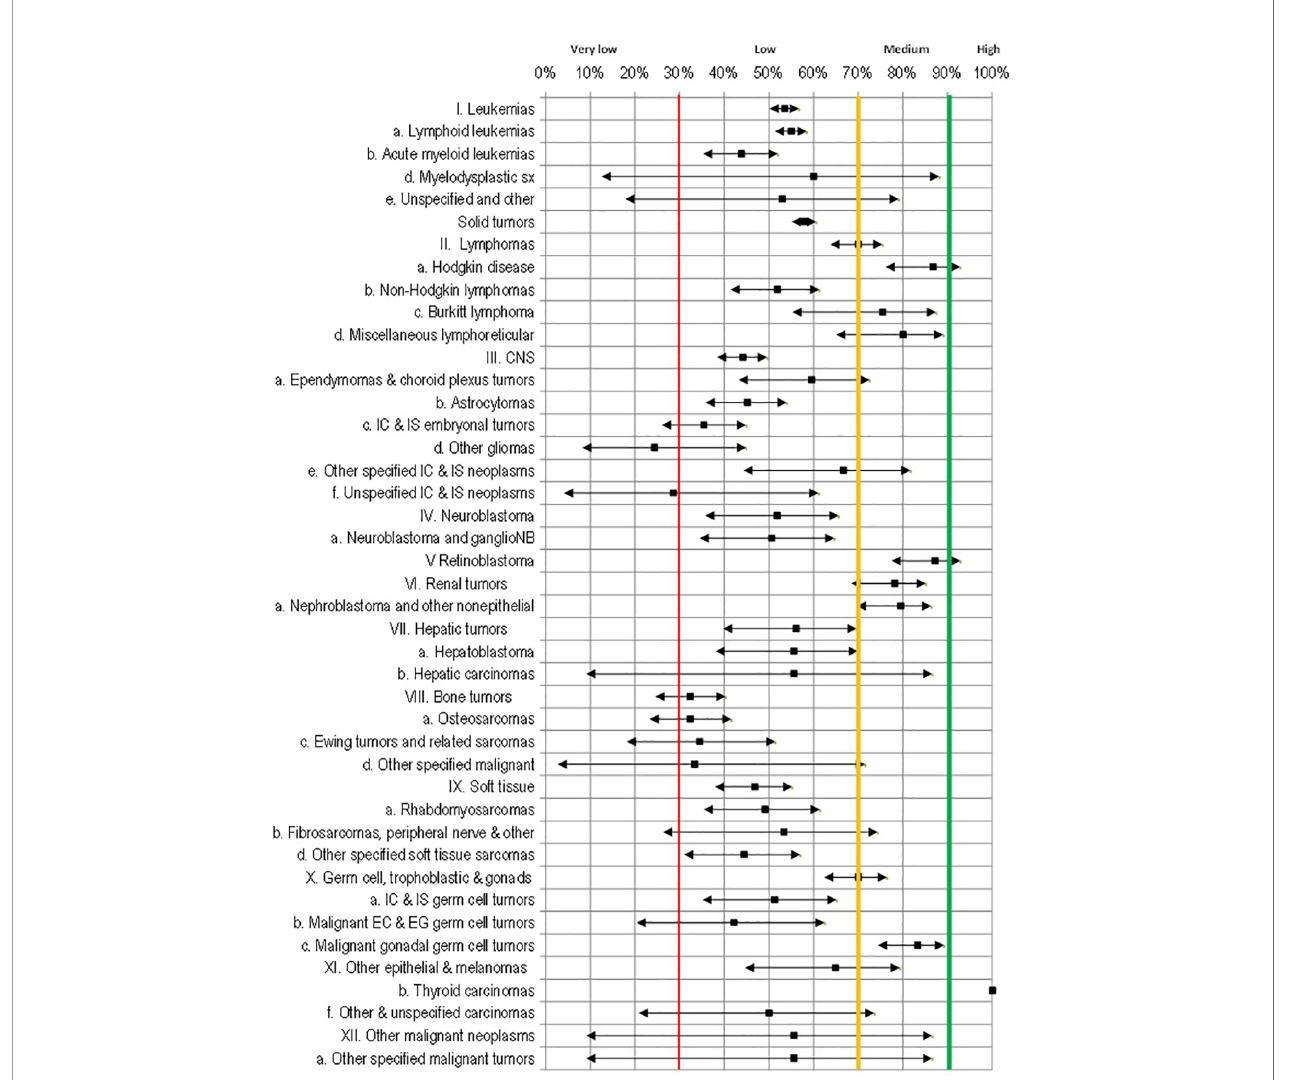
FIGURE 1 | 95% con fi dence intervals for 5-year survival rates by cancer